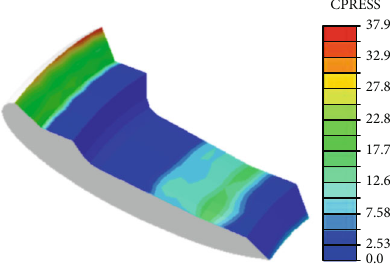
Figure 11: Distribution of contact stress for throat insert at 28 s,